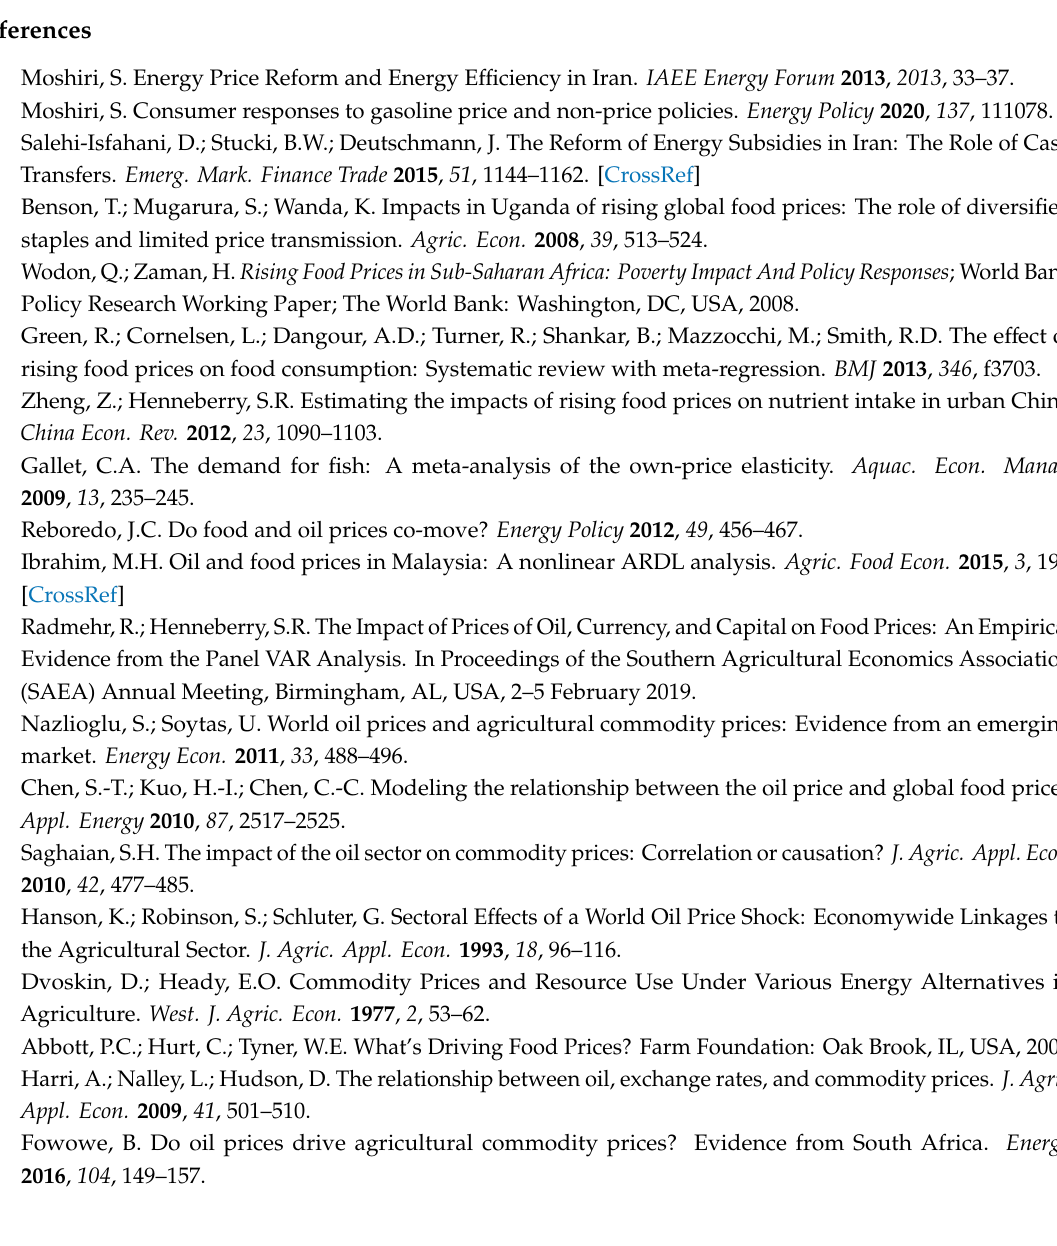
Figure A1. Impulse response function (IRF) of each food product to energy price and exchange rate shocks.